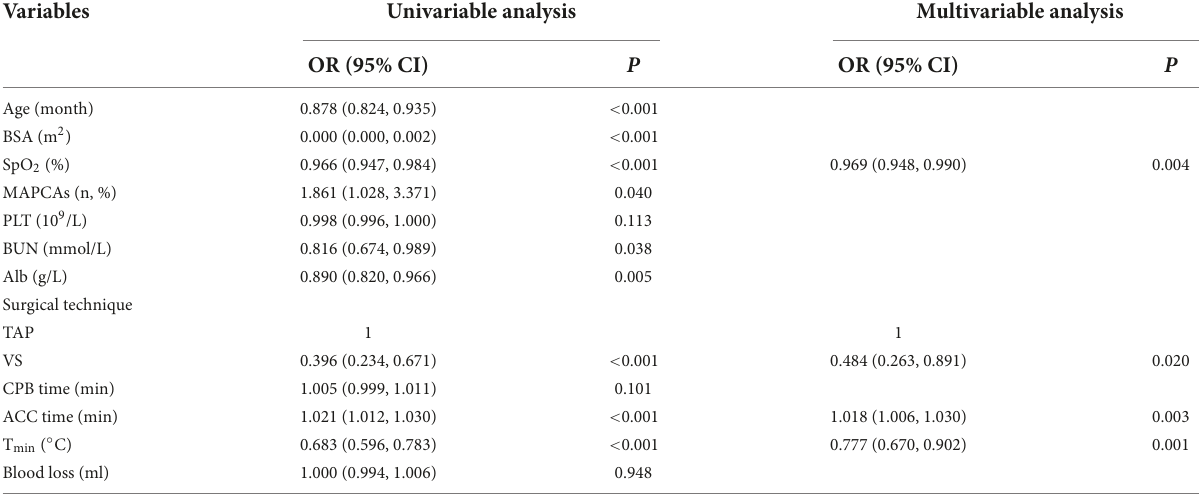
TABLE 2 Univariable and multivariable logistic regression analyses of potential risk factors in the study population. Variables Univariable